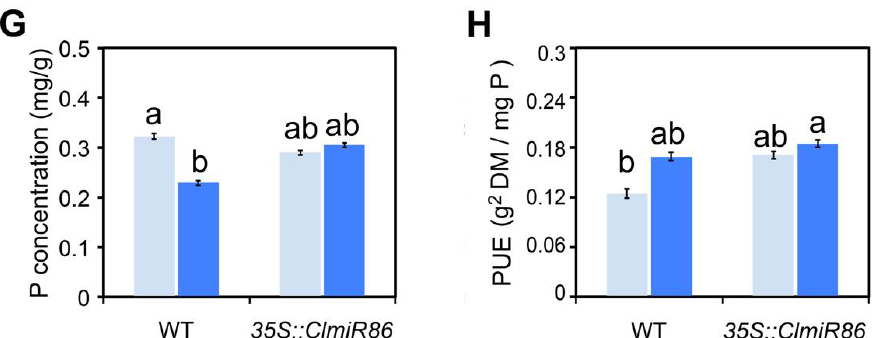
Figure 6. Phenotypes of Arabidopsis transgenic plants overexpressing ClmiR86 under P starvation conditions at adult-plant stage. ( A ) Arabidopsis Seedlings of wild type (WT; Col-0) and 35S::ClmiR86 in WT backgrounds were grown on Jiffy seedling culture substrate for 22 days and then transferred to hydroponic culture with one-half Hoagland solution containing 0.01 mM P for low P treatment for additional 7 days. ( B ) Leaf area of the wild type and 35S::miR86 plants submitted to P sufficient or deficient conditions for 7 days. ( C ) Primary root length of wild type and 35S::ClmiR86 plants submitted to P sufficient or deficient conditions for 7 days. ( D ) Root tip number of the wild